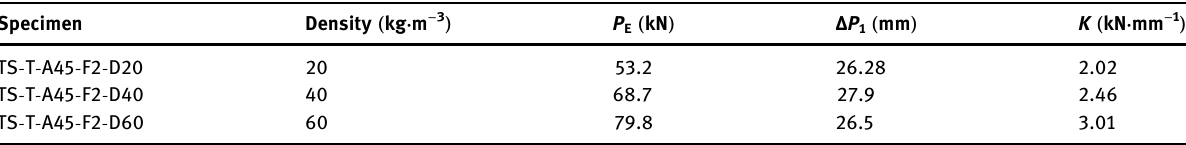
Table 8: The e ff ect of the density of foam Specimen